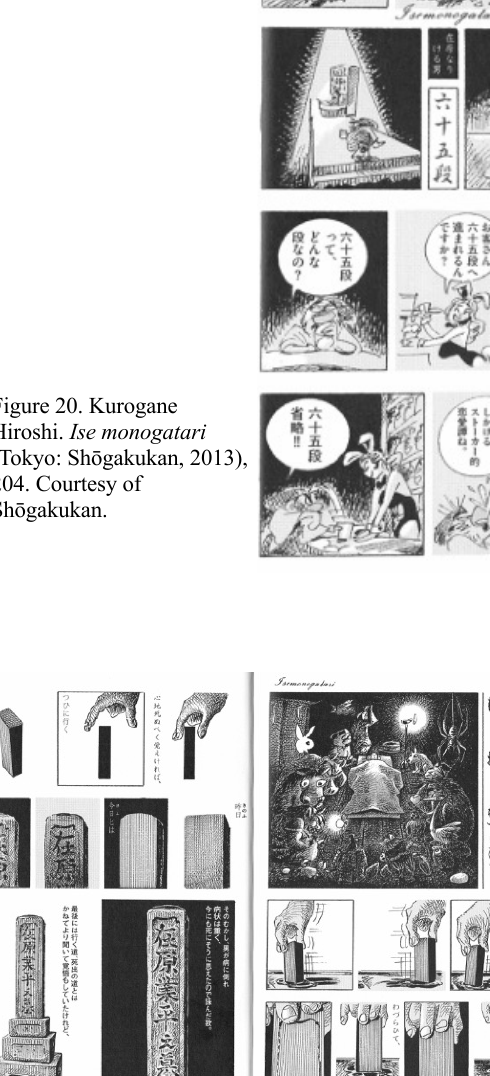
Figure 21. Kurogane Hiroshi.